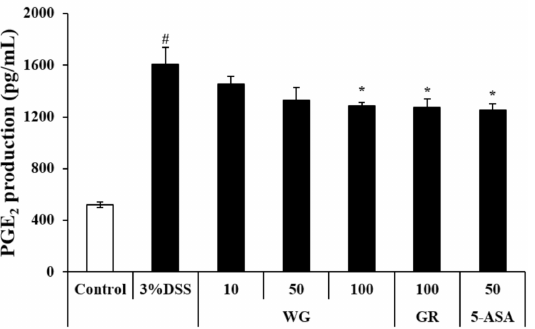
Figure 5. Effect of WG and GR extracts on prostaglandin E 2 (PGE 2 ) production in colon tissues. PGE 2 levels were measured using PGE 2 assay kits. Data are expressed as mean ± SEM ( n = 6/treatment) (#: p < 0.05 vs. control; *: p < 0.05 vs. DSS